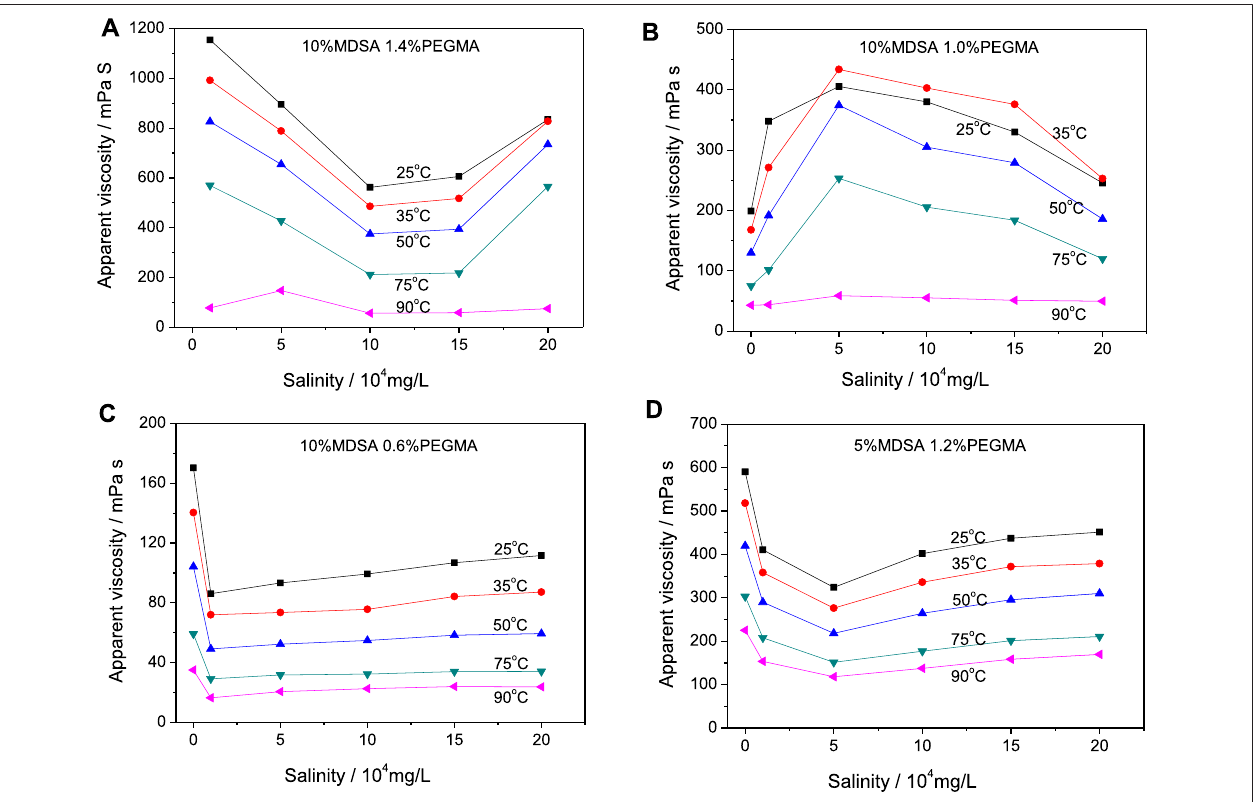
FIGURE5| Solutionviscositychangeofzp-HPAMwithn AM /n AA /n MDSA /n PEGMA of9/1/1/0.14 (A) ,9/1/1/0.10 (B) ,9/1/1/0.06 (C) ,and9/1/0.5/0.12 (D) tosalinityat different temperature.